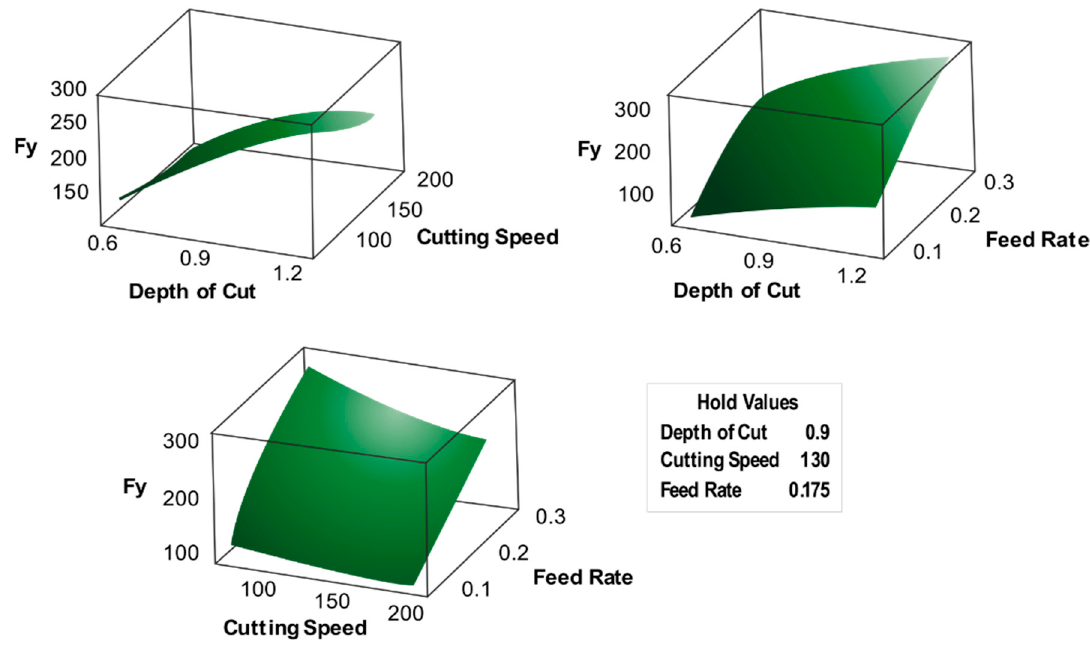
Figure 7. Response surface plot for F y . J. Compos. Sci. 2019 , 2 , x